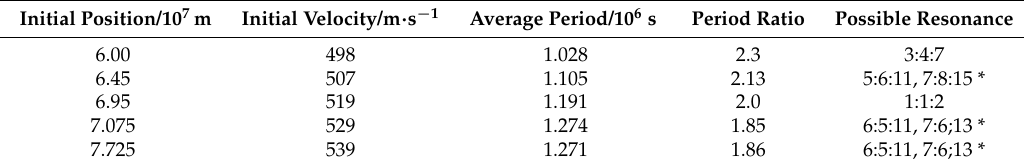
Figure 21. Identification of the five points (A–E) representing the centers of the stable islands in the high-altitude stable area. These data points are presented numerically in Table 1. Table 1. Initial conditions for points in the center of stable